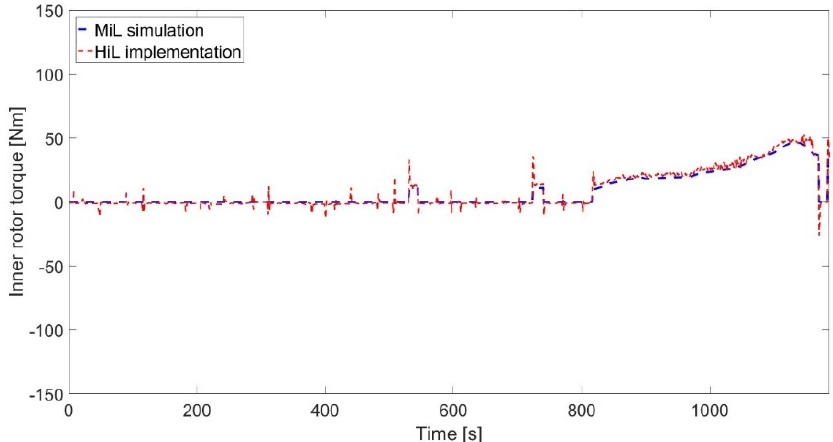
Figure 18. HiL (experimental) vs. MiL agreement results for the inner rotor torque, LPF-based EMS.